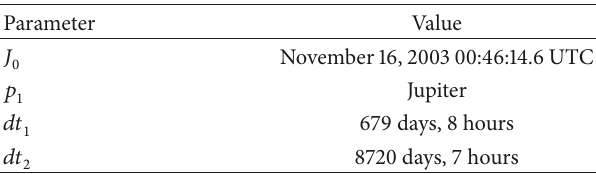
Table 7: Optimized chromosome for single planet flyby to Hylonome.